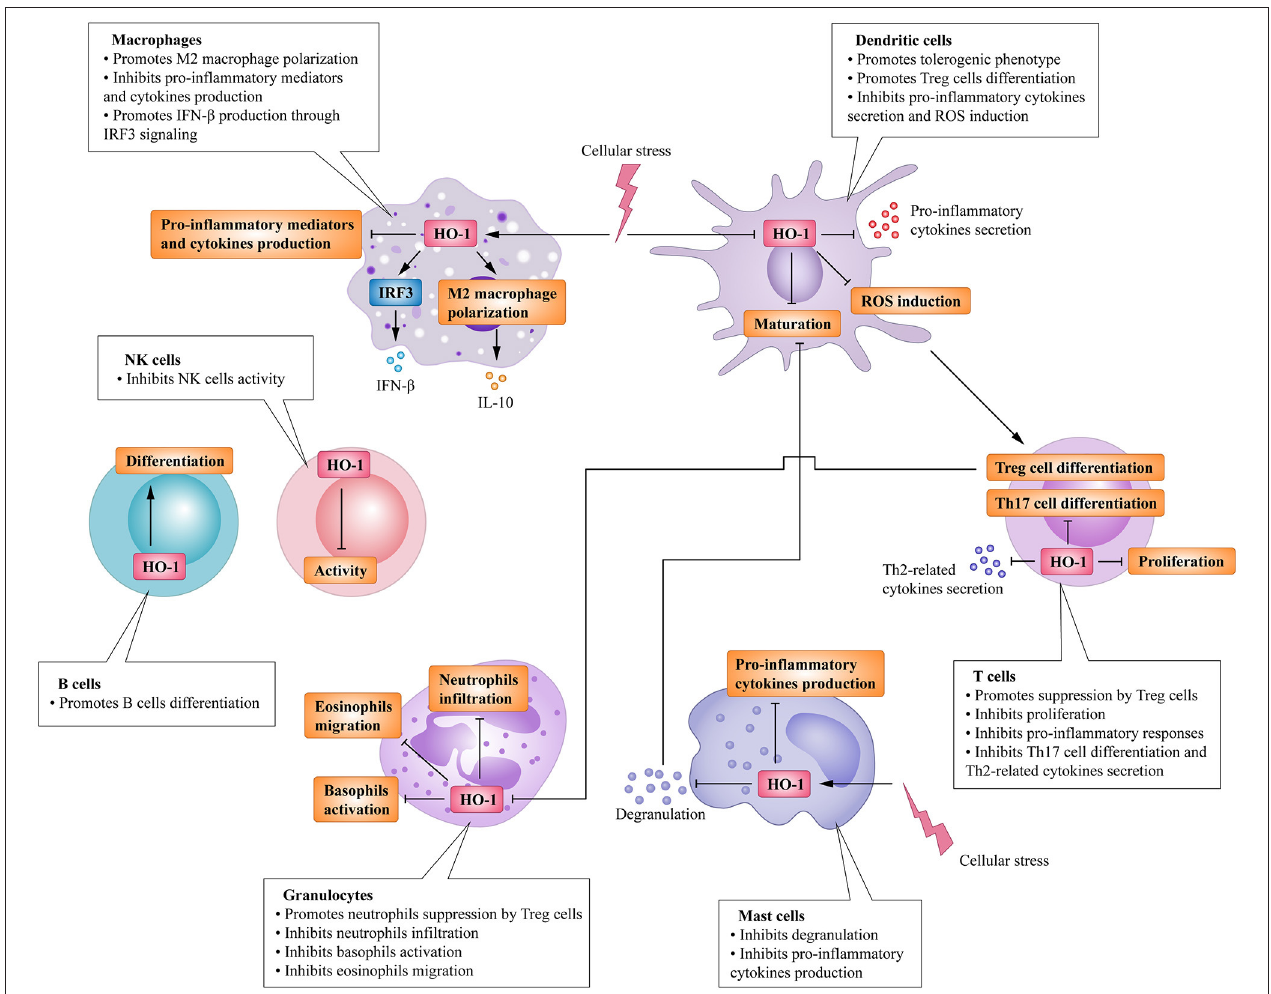
FIGURE 1 | Immunomodulatory activity of heme oxygenase 1 (HO-1) in immune cells. HO-1 is stress-inducible by macrophages and promotes the phenotypic shift to M2 macrophages, associated anti-inflammatory activities. HO-1 also modulates the production of interferon (IFN)- β in macrophages through direct HO-1 binding to interferon regulatory factor 3 (IRF3) in response to pro-inflammatory stimuli. HO-1 induction in dendritic cells (DCs) inhibits their maturation, secretion of pro-inflammatory cytokines, and induction of ROS. Mast cells (MCs) can sense local stressor insults to induce HO-1, thereby suppressing their degranulation and production of inflammatory cytokines. Moreover, inhibiting MCs’ degranulation can also inhibit DCs’ maturation. These effects all result in the promotion of DCs into a tolerogenic phenotype, thus promoting regulatory T cell (Treg cell) differentiation. HO-1 expression by T cells can additionally inhibit T helper 17 cells (TH17 cells) differentiation, Th2-related cytokines secretion, as well as limit proliferation. Activated Treg cells can initiate HO-1 expression in neutrophils shifting them to a suppressive phenotype, which inhibits their infiltration, basophil activation as well as migration of eosinophils. HO-1 expression by B cells can additionally promote their development and growth. HO-1 induction can also inhibit NK cells effector functions and